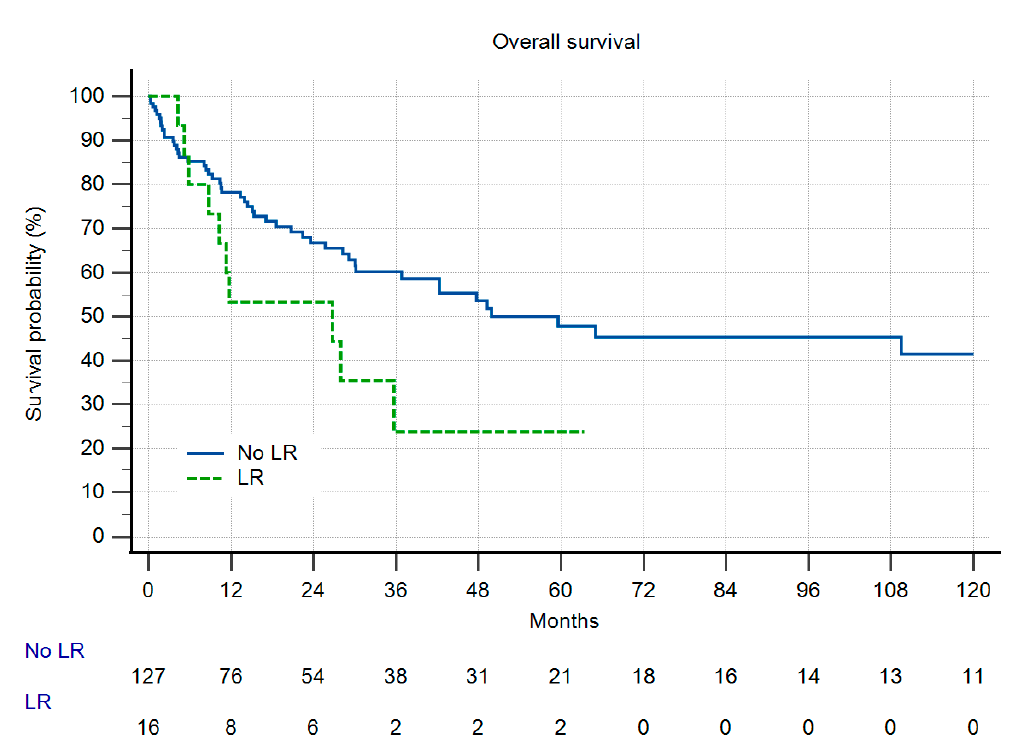
Figure 6. Overall survival by local recurrence after amputation, n = 143, six patients excluded due to insufficient data, n.s. ( p = 0.0642).